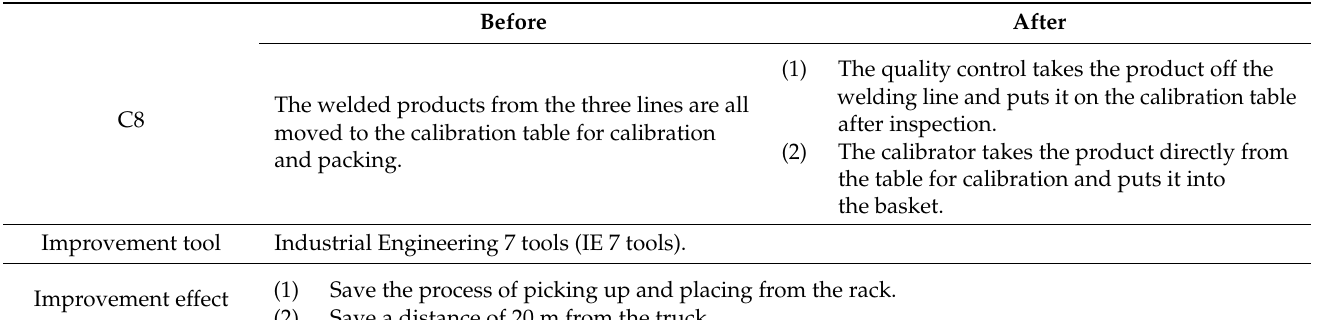
Table 12. C8 improvement project and its improvement effects (before and